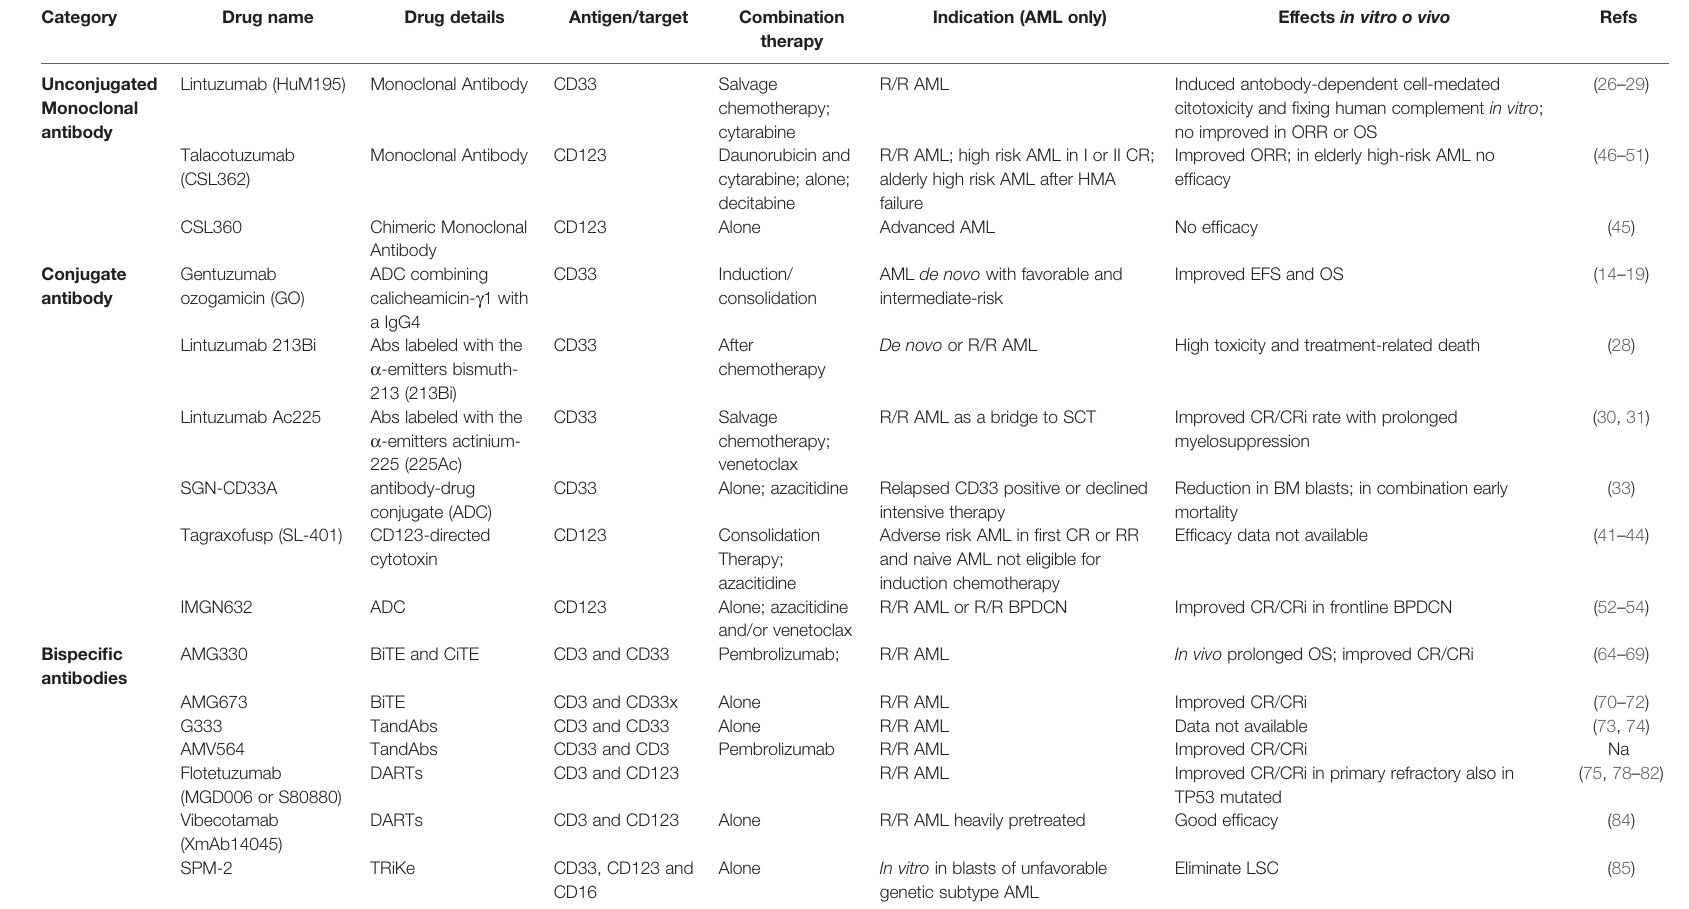
TABLE 1 | Monoclonal antibodies in